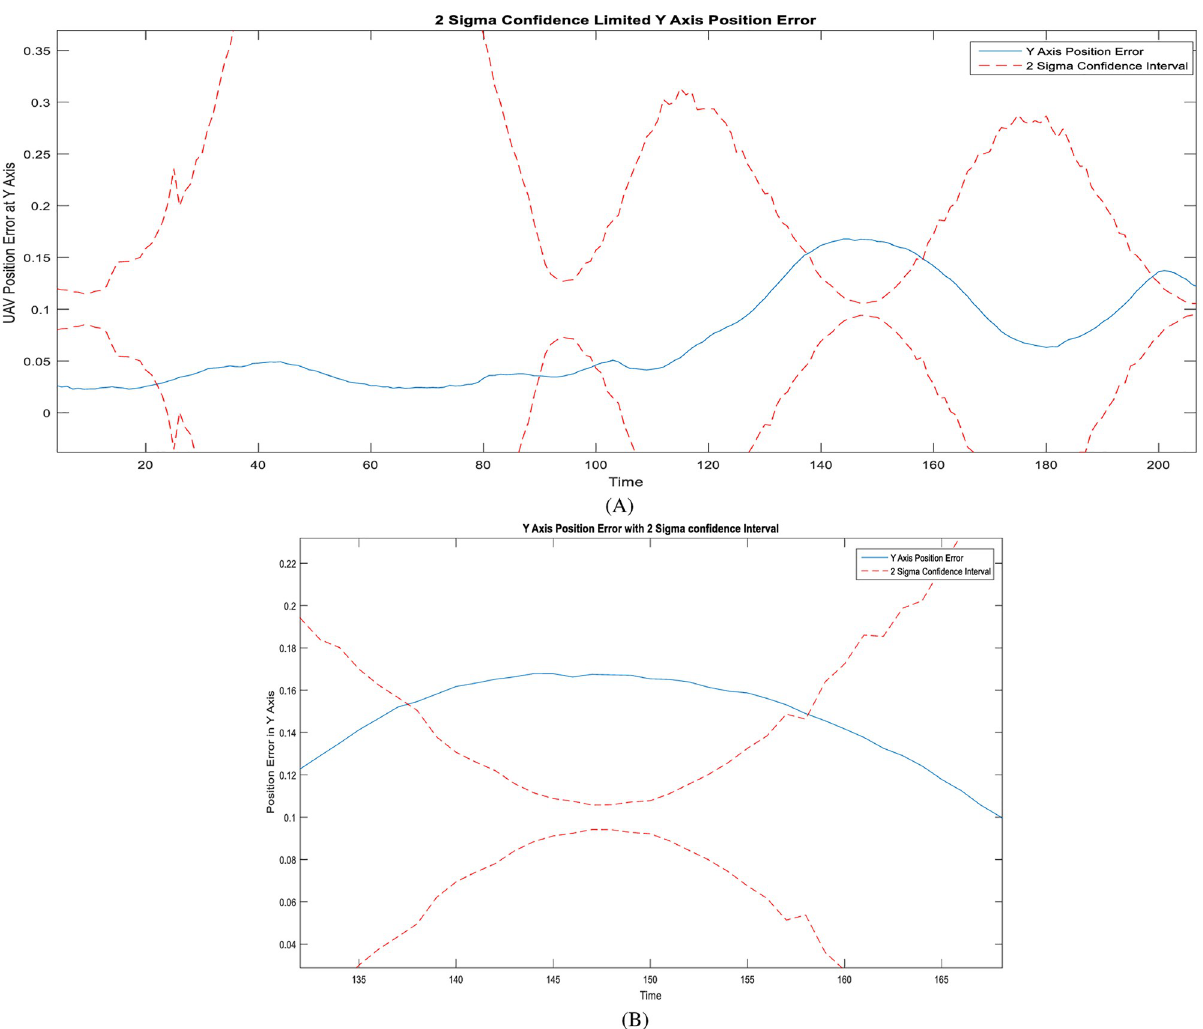
Fig 12. PFF-A-SLAM positions: Y-axis prediction errors with 2-sigma reliability limits. (A) Long-run. (B) The unreliable zone (zoom in).